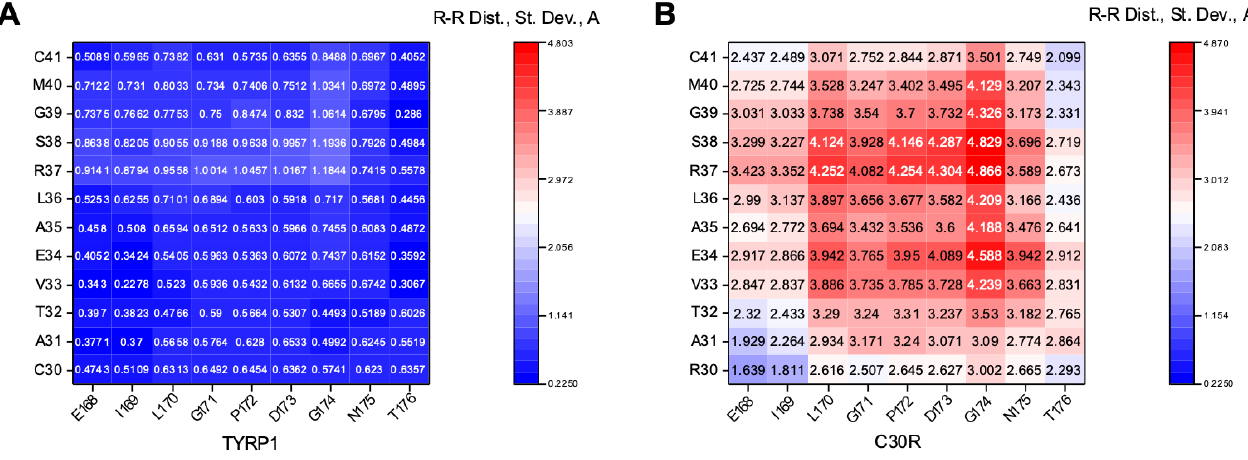
Figure 3. A portion of residue-residue distance maps of the Tyrp1 ( A ) and the C30R ( B ) structures across five timestamps: 0, 25, 50, 75, and 100 ns. Maps display the standard deviation of distances between residues. The C30-C41 region in Tyrp1 and R30-C-41 region in C30R were compared with a neighboring loop (E168-T176) to highlight the flexibility introduced by the C30R mutant within the Cys-rich subdomain. C30R shows a greater degree of fluctuation (maximum standard deviation of 4.87 Å) than Tyrp1 (maximum standard deviation of 1.19 Å).